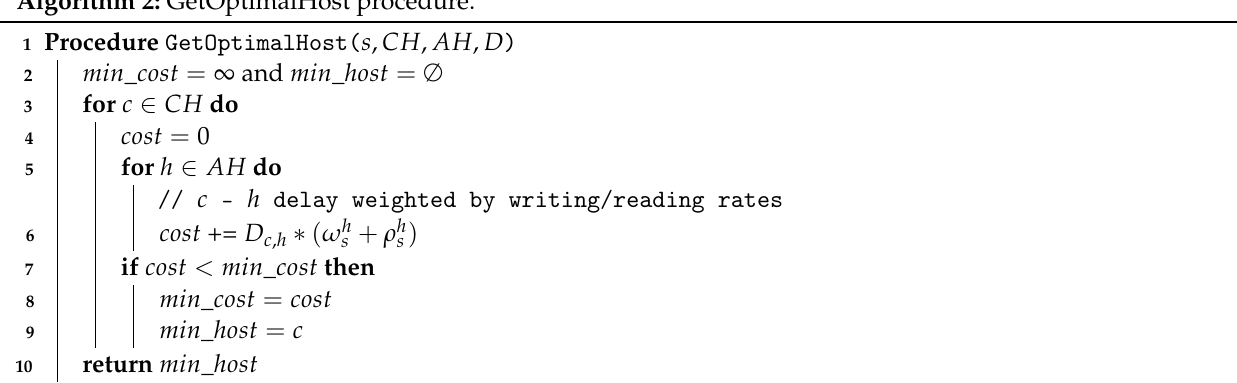
Algorithm 2: GetOptimalHost